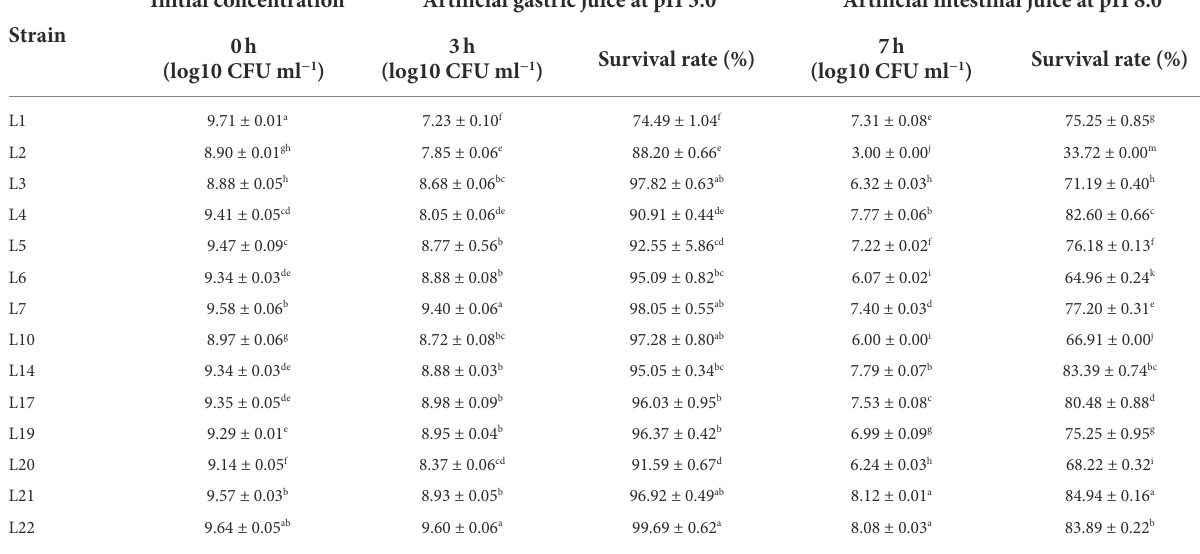
TABLE 3 Survival of the potential probiotic isolates in the artificial gastric and intestinal juices. 1